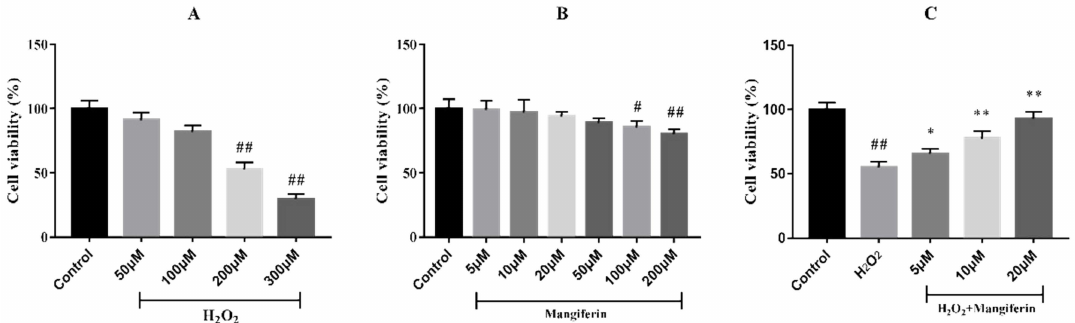
Figure 1. E ff ect of mangiferin on H9C2 cell viability after treatment with H 2 O 2 . ( A ) E ff ect of H 2 O 2 on H9C2 cell viability, ( B ) Cytotoxicity of H9C2 cell viability, ( C ) Mangiferin on H 2 O 2 induced H9C2 cell viability. ## p < 0.01 versus the control; * p < 0.05 and ** p < 0.01 versus the H 2 O 2